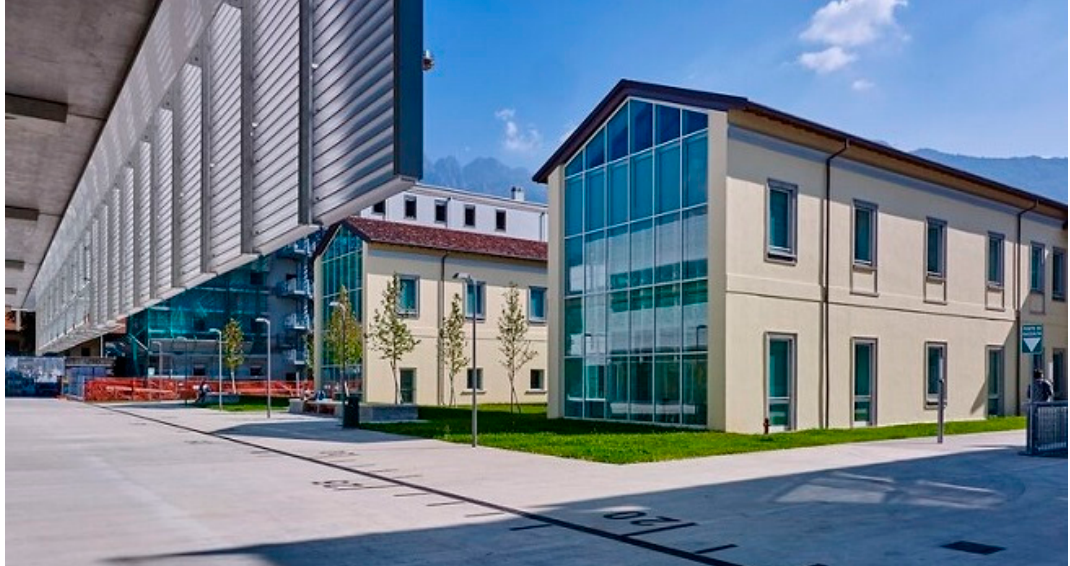
Figure 3. Building 8, Politecnico di Milano—Lecco Campus.